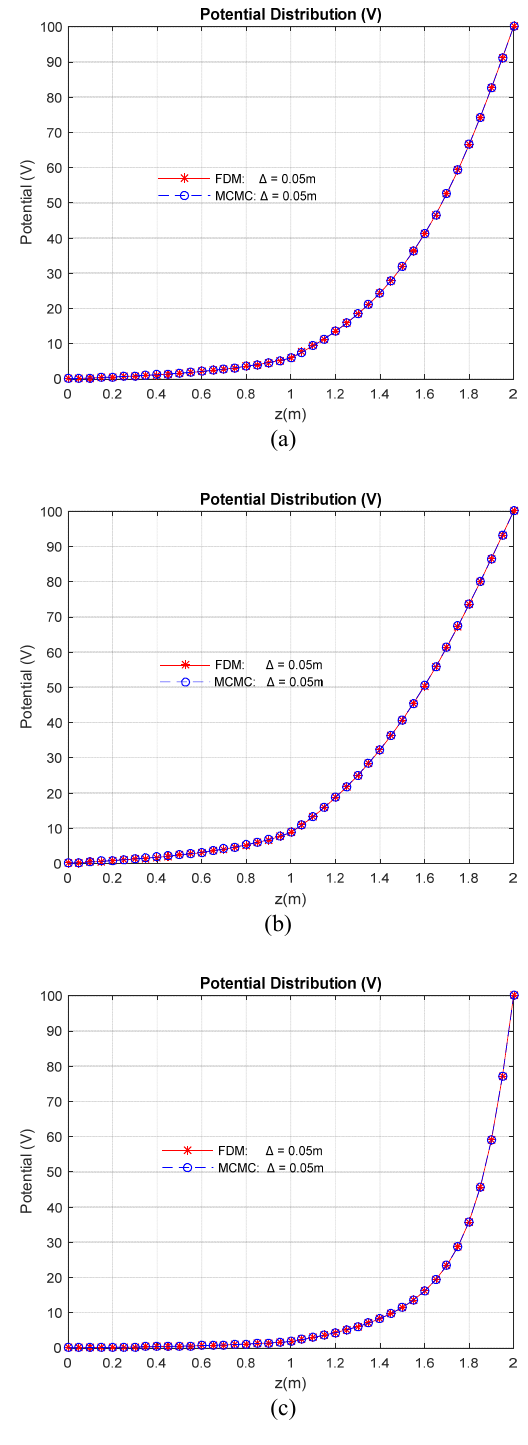
Figure 4. Potential Distribution along Inhomogeneous Problem with constant boundary